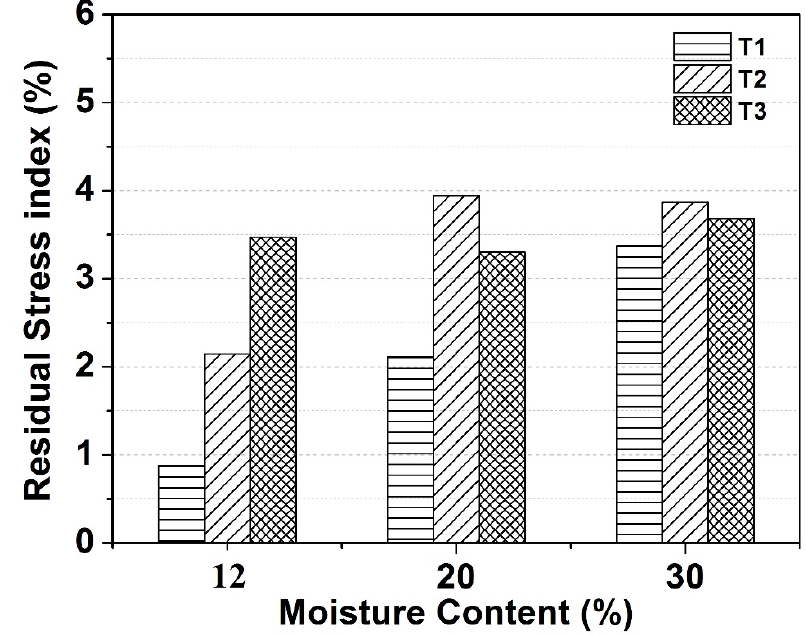
Figure 8. Stress indices of T1, T2, and T3 at the stages with 30%, 20%, and 12% MC.